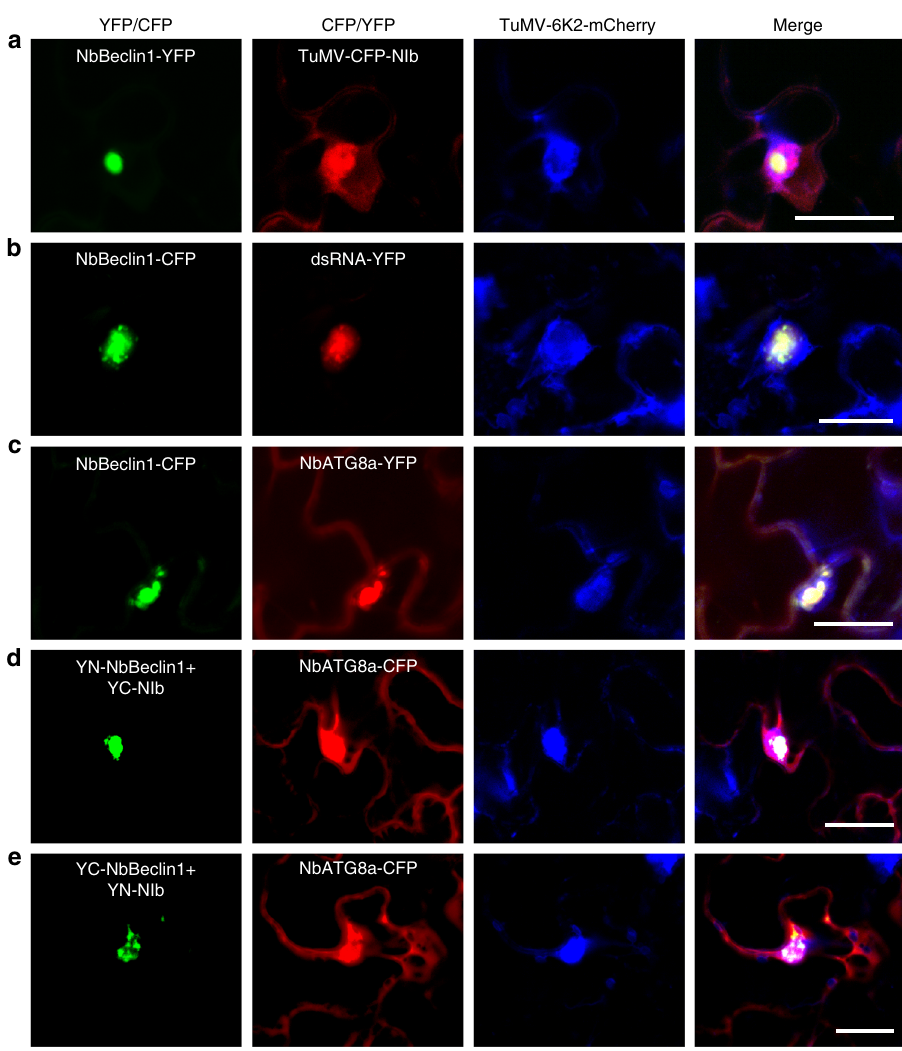
Fig. 4 NbBeclin1 or the NbBeclin1 – NIb complex co-localizes with the TuMV viral replication complex (VRC) in autophagosomes in N . benthamiana . a NbBeclin1-YFP was transiently expressed in leaf cells infected by TuMV-6K2-mCherry-CFP-NIb. NbBeclin1-YFP co-localized with CFP-NIb and 6K2- mCherry-stained aggregations. b Transient expression of NbBeclin1-CFP and a dsRNA marker (B2-YN + VP35-YC) in N . benthamiana leaves infected by TuMV-6K2-mCherry. NbBeclin1 co-localized with dsRNA in TuMV VRCs. c Co-localization of NbBeclin1 with NbATG8a and the TuMV VRC. d , e Co- localization of the interaction complex of NbBeclin1 and NIb with NbATG8a and the TuMV VRC. All confocal micrographs shown in this fi gure were taken at 72 hpi. Bars, 25 µ